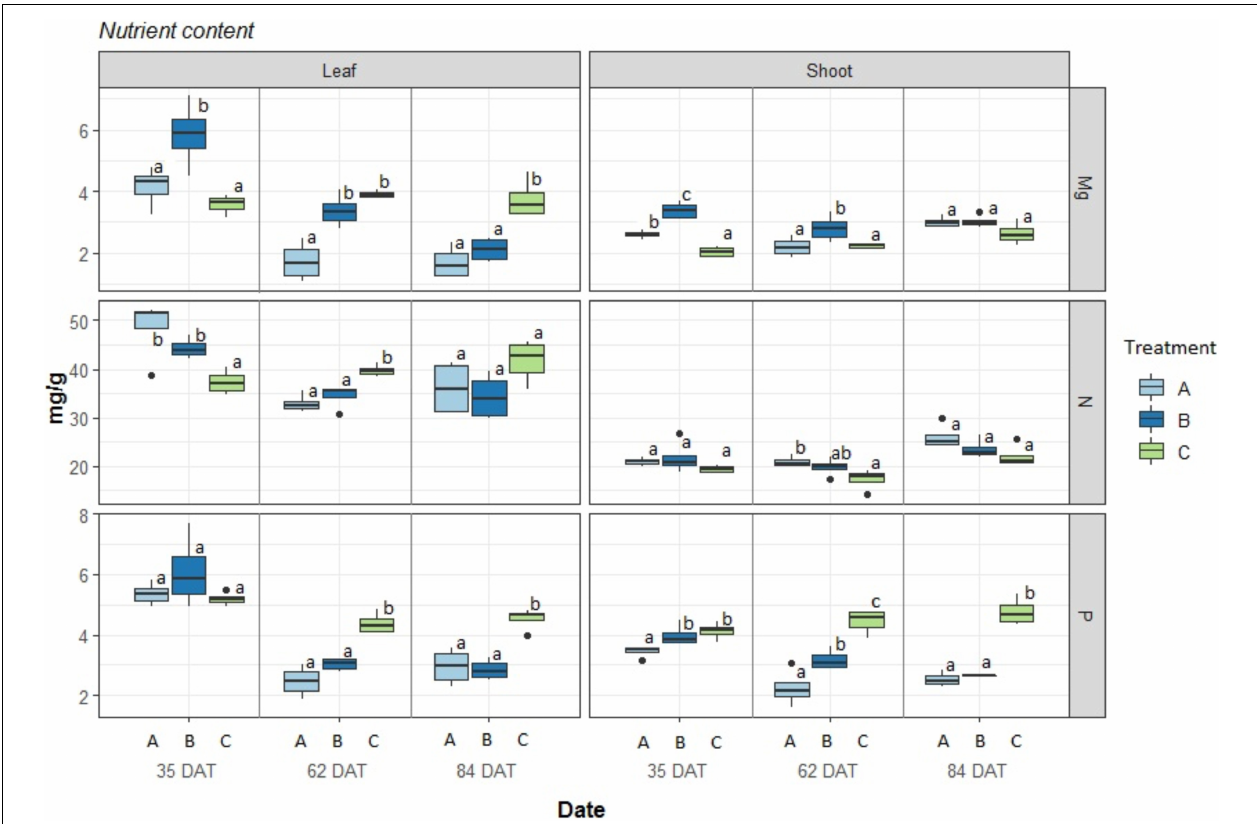
FIGURE 4 | Nutrient concentration in Phaseolus vulgaris leaves and shoots, expressed in mg/g. Boxplot ( n = 4) results given for three treatments: A = 2g of struvite + Rhizobium inoculation + P, Mg, N-free nutrient solution, B = 5g of struvite + Rhizobium inoculation + P, Mg, N-free nutrient solution and, C = standard nutrient solution - Rhizobium inoculation at three different time periods: 35 days after transplanting, 62 days after transplanting, and 84 days after transplanting. Significant differences ( p < 0.05) between treatments marked with different letter (a,b,c).